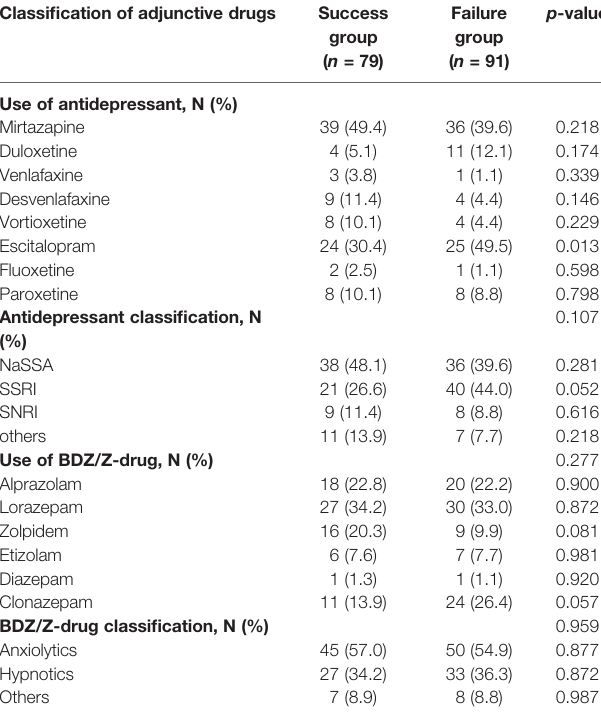
TABLE 3 | Characteristics of antidepressant or BDZ/Z-drug